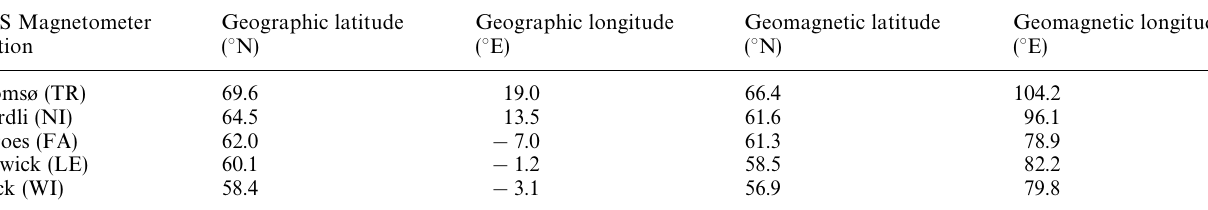
Table 1. BGS Magnetometer Geographic latitude Geographic longitude Geomagnetic latitude